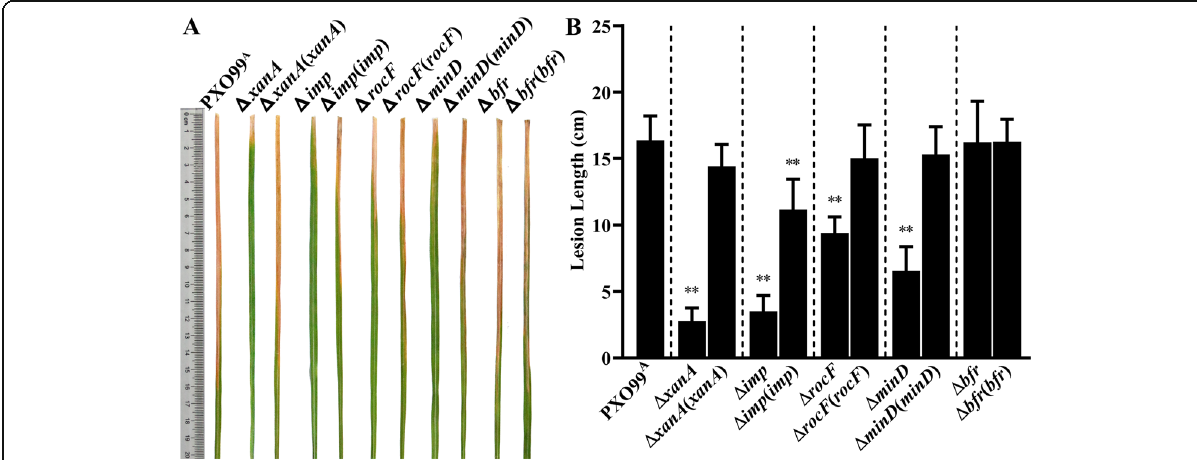
Fig. 2 Four of 5 host-induced proteins were involved in X . oryzae pv. oryzae PXO99 A virulence on susceptible rice plants. A Inoculation of PXO99 A , Δ xanA , Δ imp , Δ rocF , Δ minD , Δ bfr and their complemented strains onto the susceptible rice IR24 by the leaf clipping method. Representative disease symptoms were recorded 16 dpi (days post inoculation). B Lesion length caused by tested strains on leaves of susceptible rice IR24 at 16 dpi. Values are the means ± standard deviation (SD) from three independent experiments. Asterisks indicate significant differences compared with wild-type (t- test, ** P <0.01). PXO99 A is wild-type X. oryzae pv. oryzae ; Δ xanA , the xanA deletion mutant; Δ xanA ( xanA ), the complemented strain of Δ xanA ; Δ imp , the imp deletion mutant; Δ imp ( imp ), the complemented strain of Δ imp ; Δ rocF , the rocF deletion mutant; Δ rocF ( rocF ), the complemented strain of Δ rocF ; Δ minD , the minD deletion mutant; Δ minD ( minD ), the complemented strain of Δ minD ; Δ bfr , the bfr deletion mutant; Δ bfr ( bfr ), the complemented strain of Δ